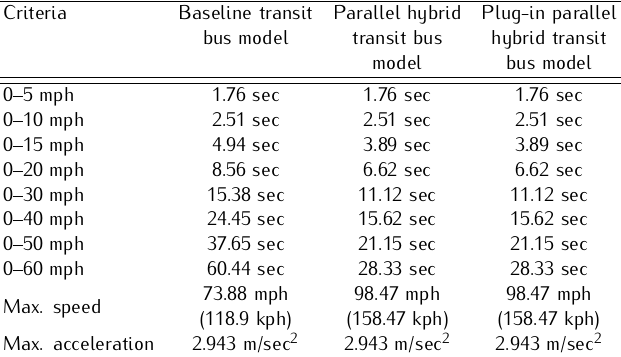
Table 5. Engine criteria used for the simulation of the different buses.